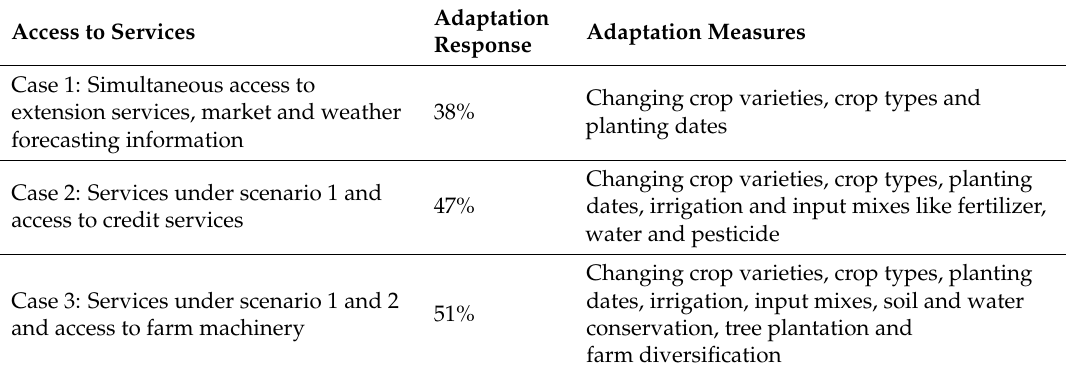
Table 3. Adoption of different adaptive measures and access to farm